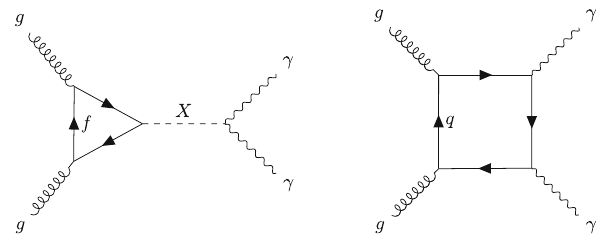
Fig. 1 Left: The gg → X → γγ signal process. The resonance X is a CP -even spin-0 particle. The f denotes heavy virtual fermions. Right: The leading order gg → γγ interfering SM background, with circulating quarks